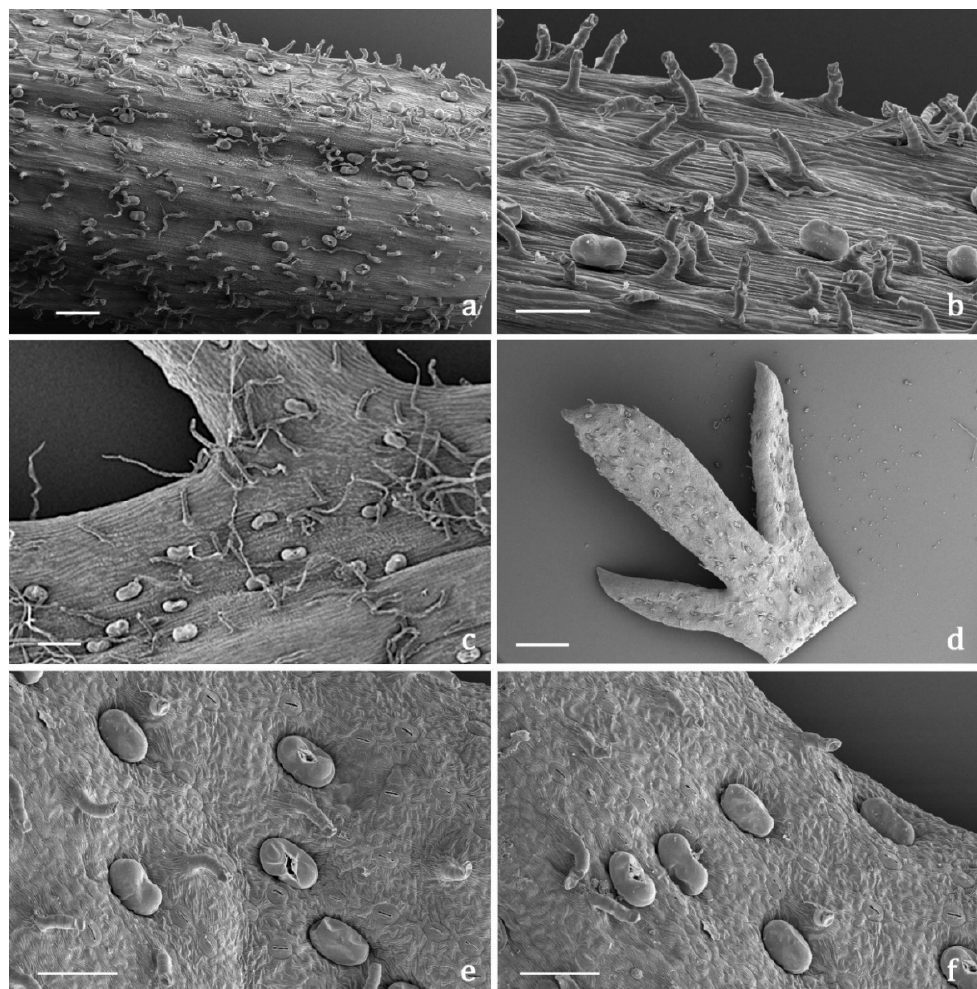
Figure 5. SEM micrographs showing the flowering stem and leaf morphology of Achillea moschata . ( a , b ) General view ( a ) and detail ( b ) of a flowering stem with biseriate glandular trichomes and digitiform covering trichomes. ( c ) Leaf abaxial surface with the two types of covering trichomes (short digitiform and long filamentous) and the biseriate glandular hairs. ( d ) General view of the apical portion of a deeply pinnate leaf (adaxial side). ( e , f ) Details of the leaf adaxial side with sunken biseriate glandular trichomes and digitiform hairs; notice the broken cuticle of several glandular trichomes for the release of the secreted materials. Scale bars: 500 μ m ( a , d ); 100 μ m ( b , c , e , f ).